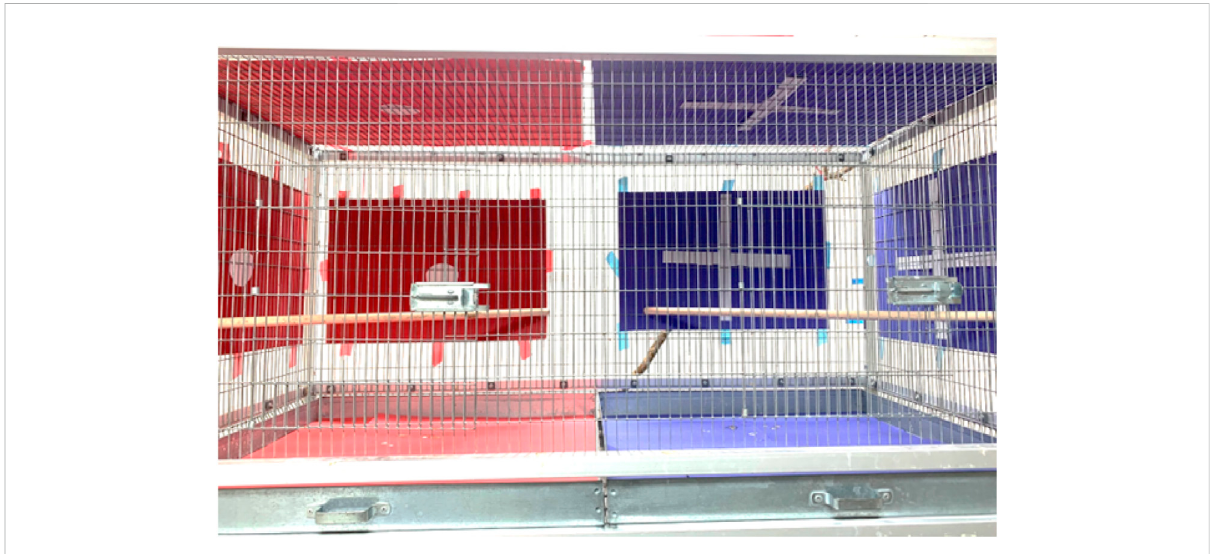
FIGURE 1 Photograph of the CPP apparatus to illustrate the two distinctly decorated conditioning compartments. On two separate days, birds were restricted to one side after saline treatment and to one side after DAMGO treatment (sides and treatments counterbalanced across birds). The next dayapartitionseparatingthetwosideswasremoved(asinthephoto)andtheamountoftimeeachbirdspentoneachsidewasrecorded.Seetextfor additional